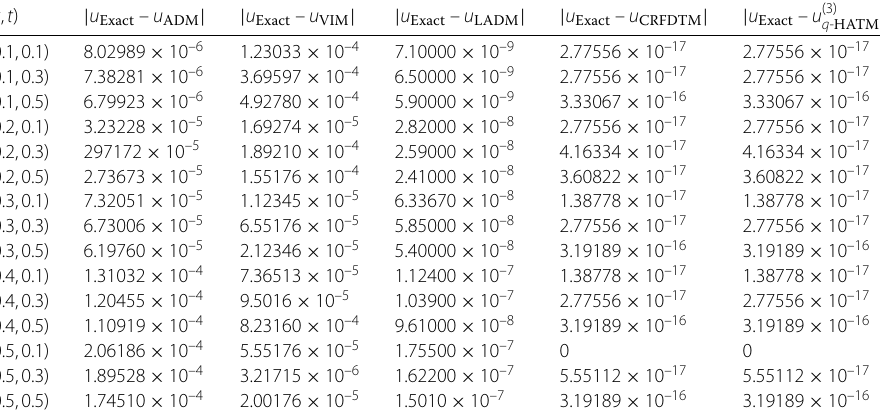
Table 3 Comparative study between ADM [28], VIM [29], LADM [30], CRFDTM [26] and q -HATM for the approximate solution u ( x , t ) at ω = 0.005, (cid:13) = 0.1, c = 10, α = 1 and (cid:2) = –1 for Example